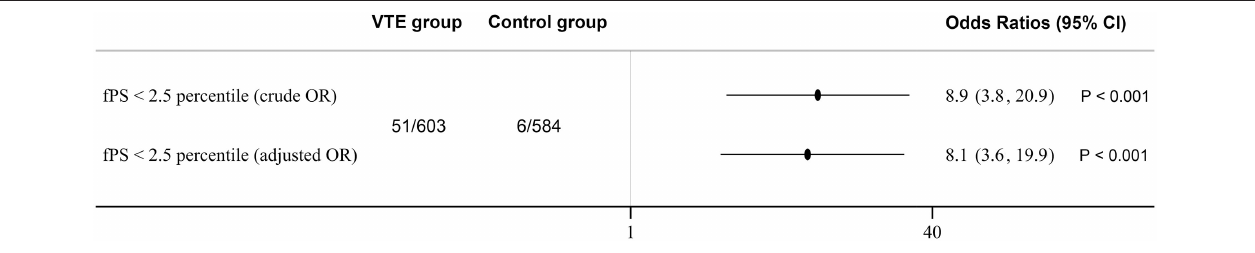
FIGURE 1 | Protein S deficiency and risk of venous thromboembolism. Odds Ratios were adjusted for age and gender. 95% CI indicates 95% confidence intervals.